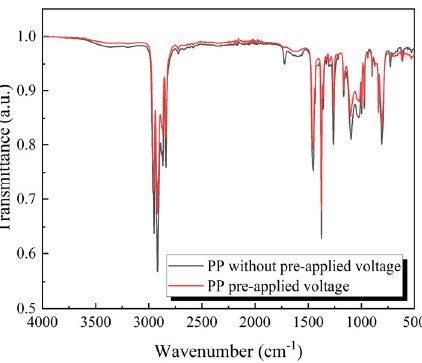
Figure 6. Infrared spectra of PP before and after pre-applied voltage.